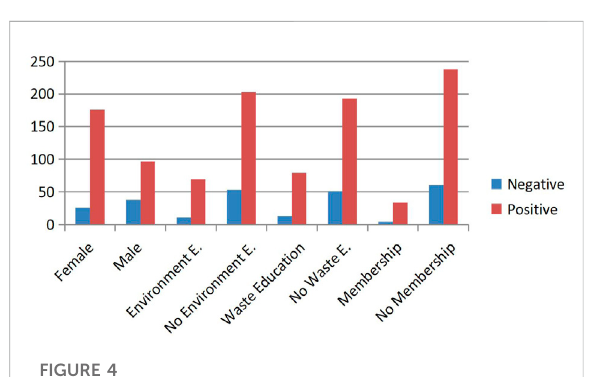
FIGURE 4 Module two additive sums of positive and negative